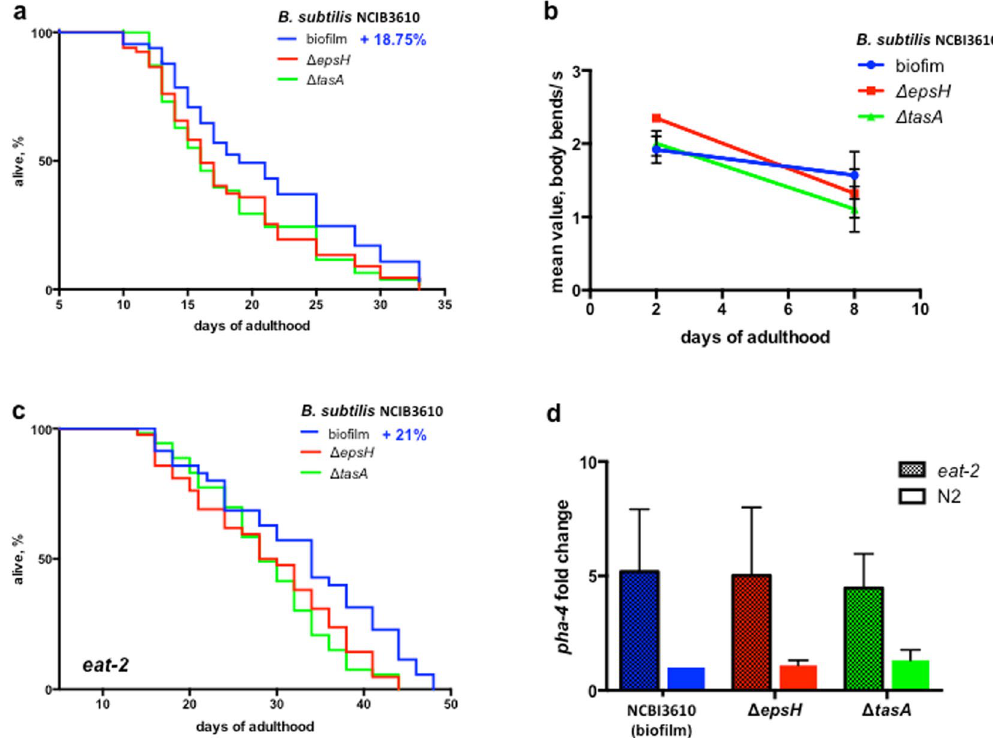
Figure 2. B. subtilis biofilm extends C. elegans lifespan independently of caloric restriction. ( a ) C. elegans N2 were fed either biofilm-forming B. subtilis NCBI3610 (biofilm) or its biofilm-deficient derivatives ( Δ epsH or Δ tasA ). The graph is representative of three independent biological replicates. Median lifespan, days: biofilm–19; Δ epsH –16; Δ tasA –16. The log-rank test p-value for each experiment is ≤ 0.05. Also see Supplementary Table S3. ( b ) Worms fed on biofilm-producing B. subtilis exhibit slower age-associated decline in motility. The graph represents linear regression of the median motility values of day-2 and day-8-adults grown of biofilm-forming (biofilm) or biofilm-deficient ( Δ epsH , Δ tasA ) B. subtilis . The median values were calculated as described in Supplemental Fig. S3d and mean values ± SD from 3 independent experiments are plotted. ( c ) The biofilm prolongs lifespan of dietary restricted worms DA1116 ( eat-2 ). Median lifespan, days: biofilm–34; Δ epsH –29; Δ tasA –28. The graph is representative of three independent biological replicates. The log-rank test p-value is ≤ 0.05, Supplementary Table S3. ( d ) pha-4 is induced in response to dietary restriction, but not by the B. subtilis biofilm. RT-PCR analysis of pha-4 expression in C. elegans eat-2 (dashed bars) and N2 (empty bars) fed biofilm-forming (biofilm) and biofilm deficient ( Δ epsH , Δ tasA ) B. subtilis strains. Mean ± SD from three independent experiments are plotted, n = 100 per experiment per condition. One-way ANOVA: p - value = 0.6696 for N2 worms; p -value = 0.1945 for eat-2